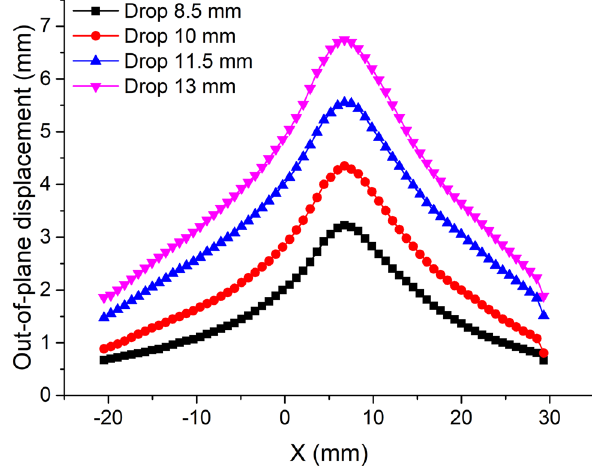
Figure 12: Out - of plane displacement distribution along x